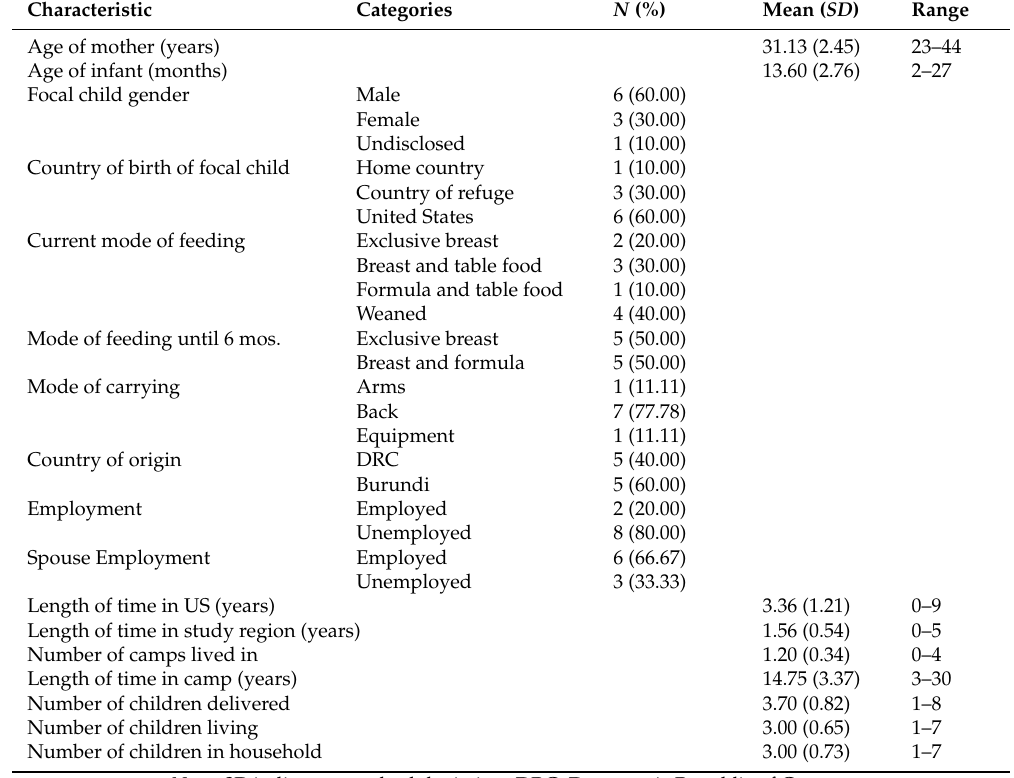
Table 1. Demographic characteristics of participants ( N =